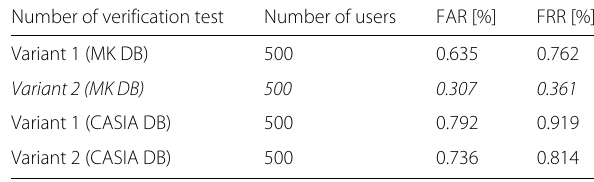
Table 1 Comparing results of localization of points in automatic and manual way Kind of test No. of No. of Percentage No. of Percentage images correct of correct incorrect of incorrect Table 2 Results of tests for identity verification based on the Approxim. of asymmetry of the face, for the first and second variant of the test corners of the Number of verification eyes Approxim. of corners of the Approxim. of points of the